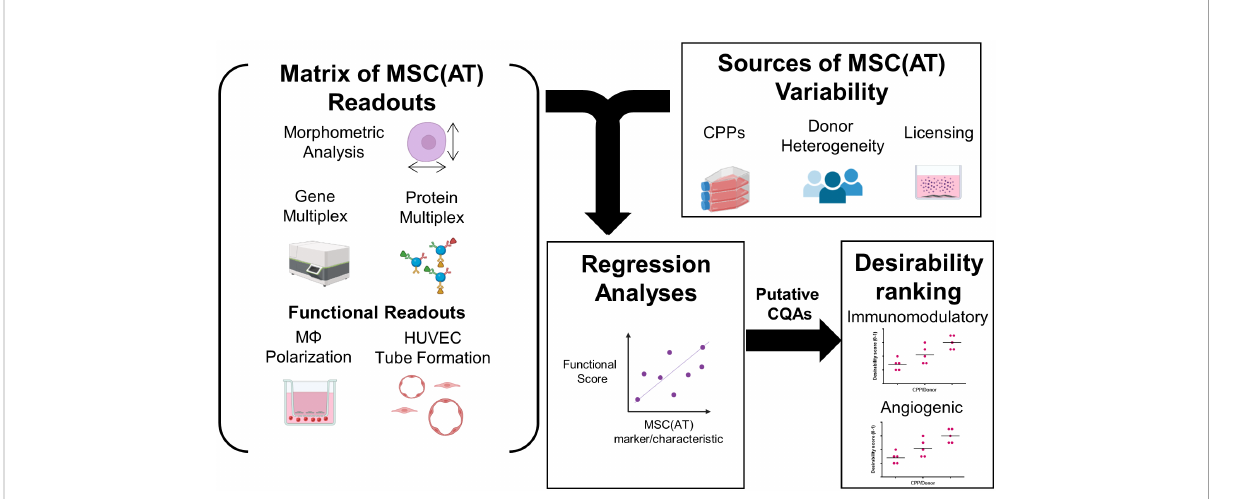
FIGURE 1 Schematic of experimental and statistical analyses to identify a putative matrix of critical quality attributes sensitive to changes in speci fi c critical processing parameters that enhance MSC(AT) potency. The overarching aim of this study was to evaluate the response of putative critical quality attributes (CQAs) to variations in culture conditions, critical processing parameters (CPPs) selected for their known ability to enhance potency, and donor heterogeneity of MSC(AT). To do this, a matrix of assays consisting of morphometric analysis (of single cell suspensions), gene multiplex (58-gene panel), soluble factor analysis (10-analyte panel), in vitro monocyte/macrophage (M F ) polarization (functional immunomodulatory assay), and in vitro human umbilical vein endothelial cell (HUVEC) tube formation assays (functional angiogenic assay) was applied. The matrix of MSC(AT) assays was sensitive to variations in CPPs (including 3D normoxic, 2D hypoxic, and 2D normoxic conditions), donor heterogeneity (N=5 human MSC(AT) donors), and to licensing with pro-in fl ammatory cytokines. Changes in the matrix of gene and protein expression pro fi les of MSC(AT), and morphological features correlated with functional immunomodulatory and angiogenic readouts by regression analyses to re fi ne a panel of putative MSC(AT) CQAs. Desirability pro fi ling of these putative CQAs allowed ranking of the effects of CPPs or donor heterogeneity on desired immunomodulatory or angiogenic